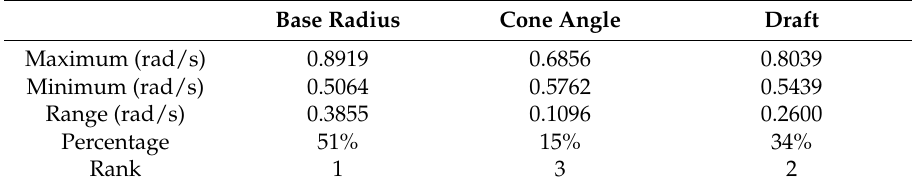
Table 7. Degree of influence of geometric parameters on absorption bandwidth.